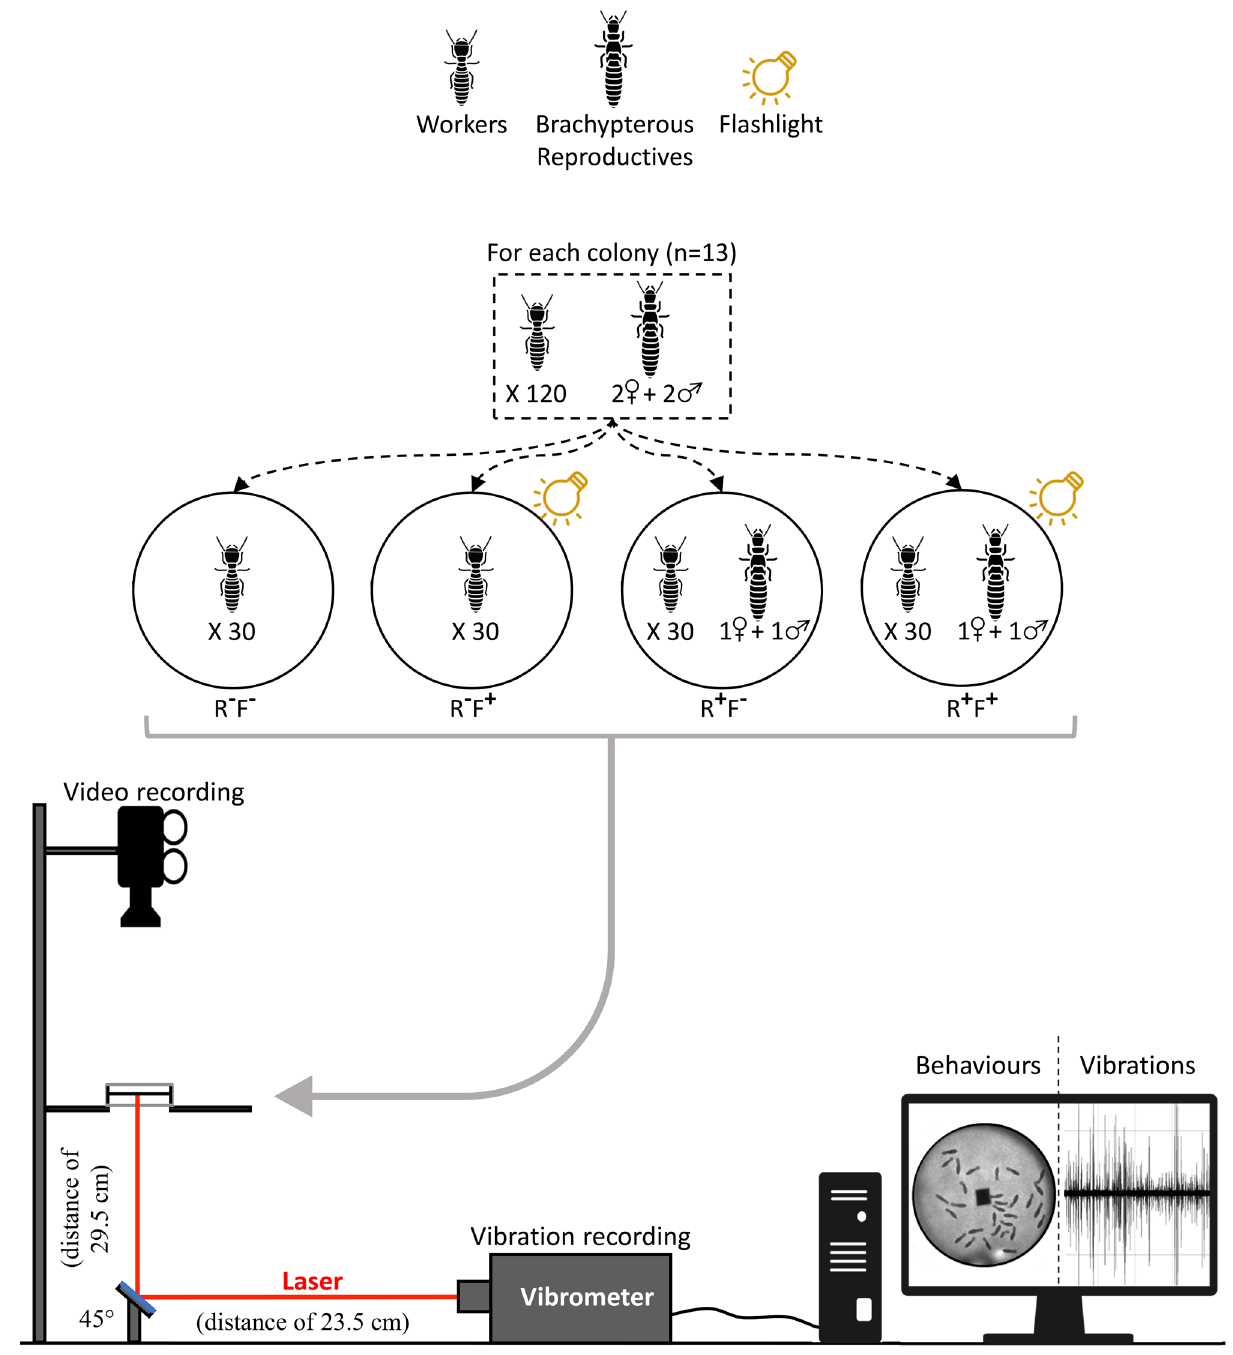
Figure 1. Experimental design representing the different treatments, the video recordings of the behaviour events, and the laser recordings of the emitted vibrations. Workers in presence of reproductives and flashlight ( R + F + ), in presence of reproductives ( R + F − ), in presence of flashlight ( R - F + ), and in absence of reproductives and flashlight ( R - F -